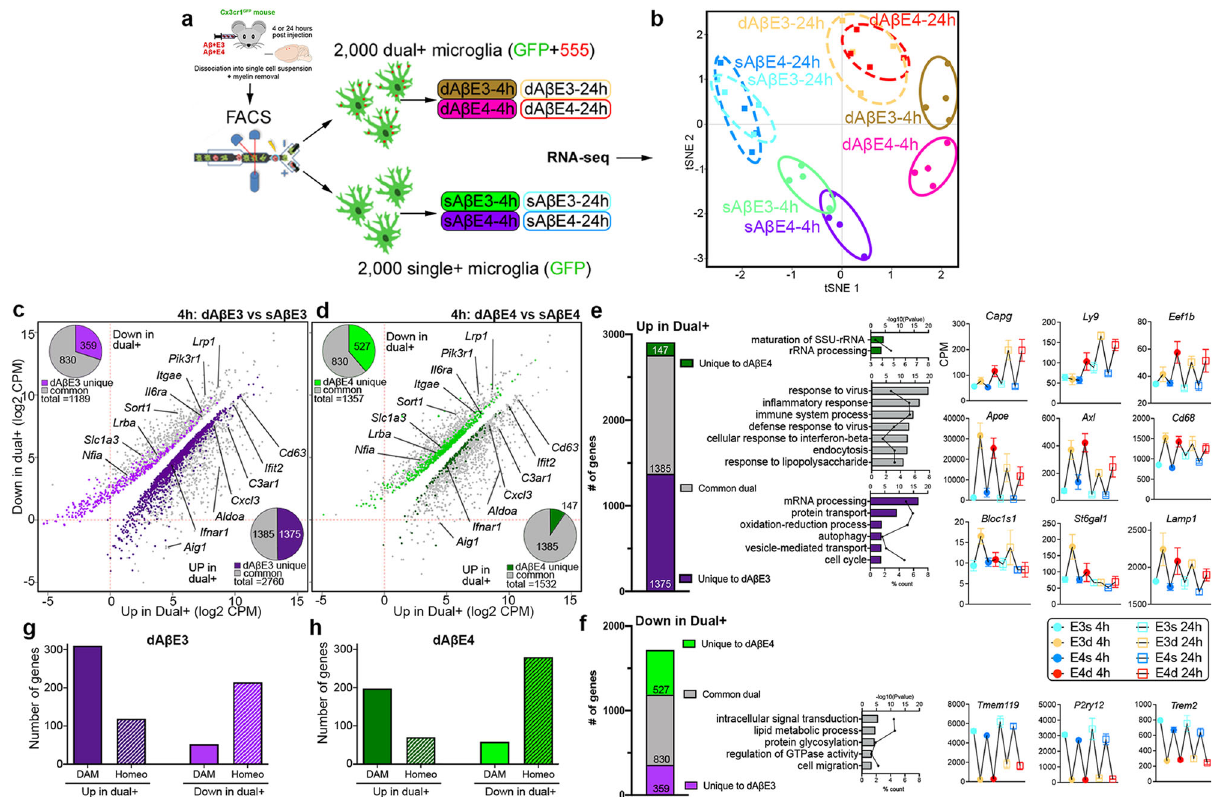
Fig. 4 A β E3 and A β E4 differentially affect microglia transcriptome. Cx3cr1GFP mice were infused with A β E3 or A β E4, brain and processed followed by FAC sorting microglia at 4 and 24 h into single + (referred to as sA β E3 or sA β E4) and dual + (dA β E3 or dA β E4) populations and used for RNA-seq. a Experimental design. b tSNE plot shows clustering of dual + and single + microglia for four experimental groups. n = 4 mice/group c , d Signi fi cantly affected transcripts for dual + vs. single + microglia at 4 h time point (FDR <0.05) for A β E3 (purple) and A β E4 (green) groups. c DEGs in dA β E3 vs. sA β E3. d DEGs in dA β E4 vs. sA β E4. Pi charts in the upper left (down in dual + ), and lower right (up in dual + ) represent genes common between, or unique to each APOE isoform. e , f Proportion of genes, GO terms and line patterning associated with common (gray) or unique genes between dA β E3 vs. sA β E3 (purple) and dA β E4 vs. sA β E4 (green). e Common and unique upregulated in dual + vs. single + . f Common and unique downregulated in dual + vs. single + . For both, bar plots indicate the − log10 P value for each term, and the associated point in the center of each bar represents the percent of submitted genes found in each GO term. Line-patterning graphs show example of genes from each category. sA β E3 light blue, dA β E3 beige, sA β E4 blue, dA β E4 red; 4 h solid cirles, 24 h open circles. g , h Bar graphs show the number of DAM (solid) and homeostatic (dot pattern) genes upregulated or downregulated in dual + for A β E3 ( g , purple) or A β E4 ( h , green) injected